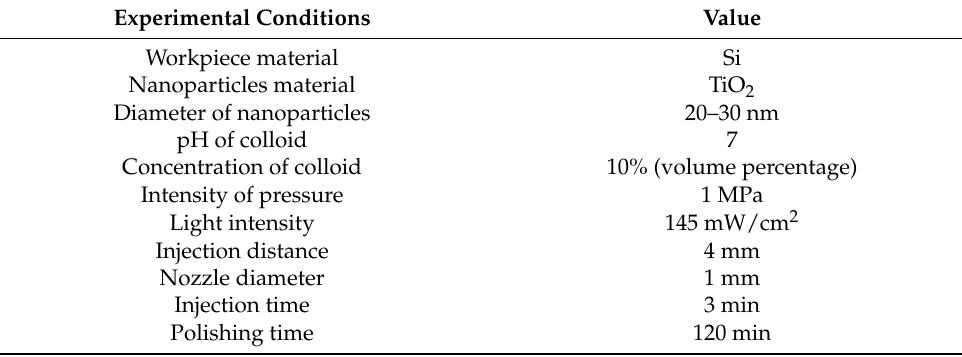
Table 1. Relevant parameters in the adsorption and polishing experiments.